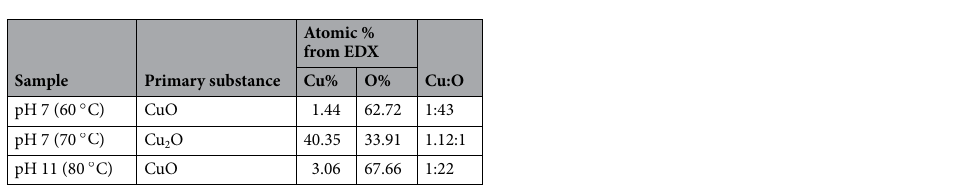
Table 2. The Cu to O ratio is based on the atomic percentage obtained from the EDX results.